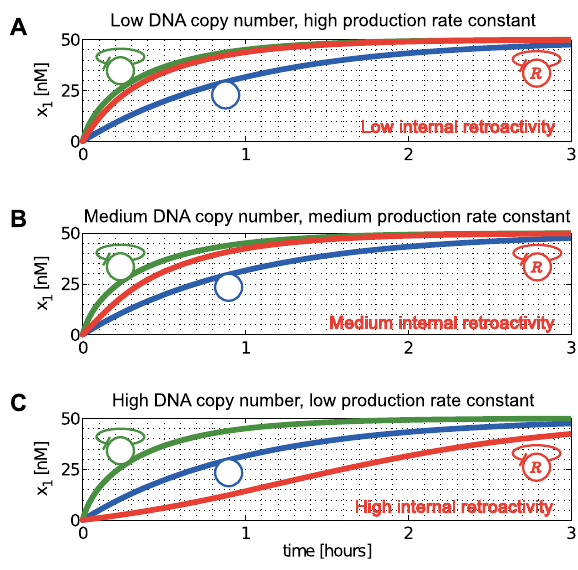
Figure 4. Negative autoregulation can make the temporal response slower. Time response at a steady state fixed at x 1 ~ 50nM . The red and blue plots denote the cases with and without negative autoregulation, respectively, whereas the green plot represents the case of negative autoregulation neglecting retroactivity ( R ~ 0 in (8)). Simulation parameters are d 1 ~ 1hr { 1 , k 1 ~ 10nM , together with regulated systems, we compare the response time of systems with the same steady state. To do so, we pick the same value of g 1 in the case of the regulated systems ( g 1 ~ 15nM , g 1 ~ 30nM , g 1 ~ 300nM for A, B and C, respectively), but a different one for for the unregulated system